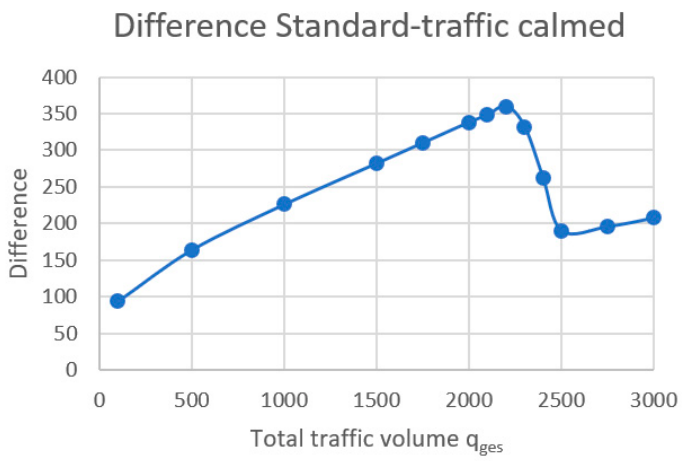
Figure 20. Difference in traffic volume between links with the same volume–delay function and different v 0 velocities, source: